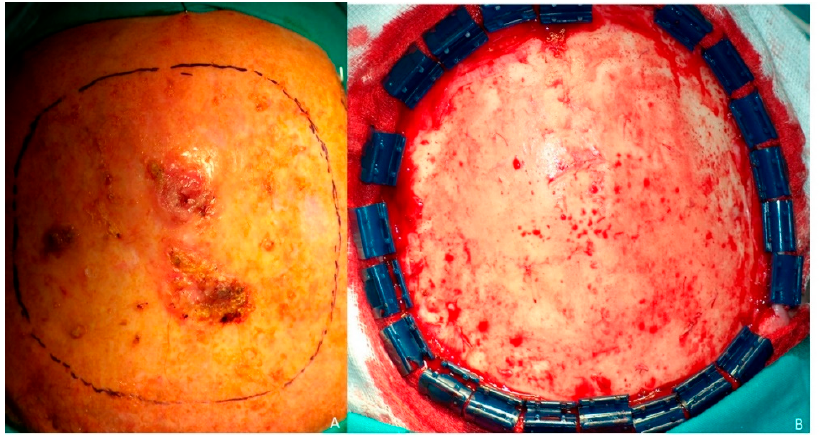
Figure 1. Omental flap. ( A ) Recurrent squamous cell carcinoma of the scalp. ( B ) Full-thickness defect of scalp after resection of the tumor and resection of the surrounding fibrous tissue.